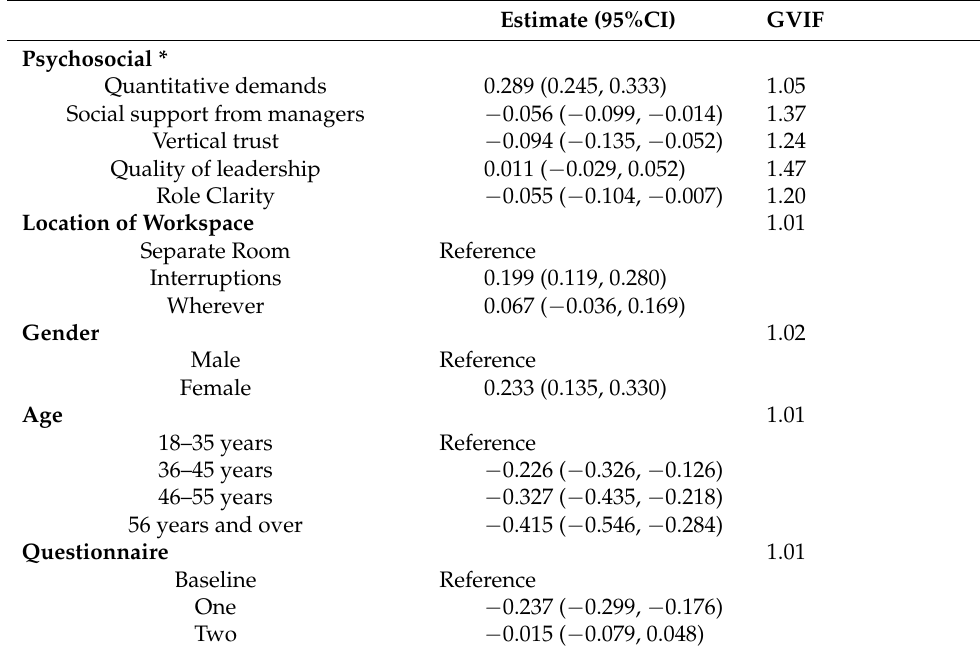
Table 2. Associations between stress and psychosocial factors and